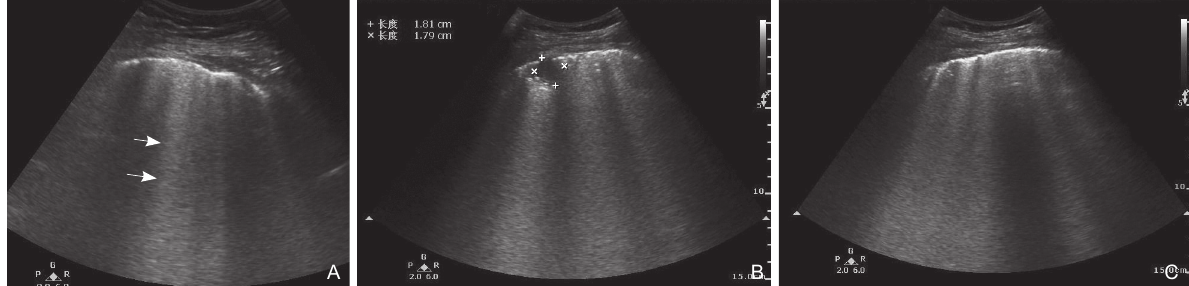
Figure 9 COVID-19 ultrasound images. (A) Thickened and rough pleural line, A-line disappeared with and increased number of B-lines (arrows); (B) Consolidation of the subpleural lung (indicated by measurement cursors); (C) Thickened pleural lines, interrupted echo, and increased and merged B-lines with the interval ≤ 3